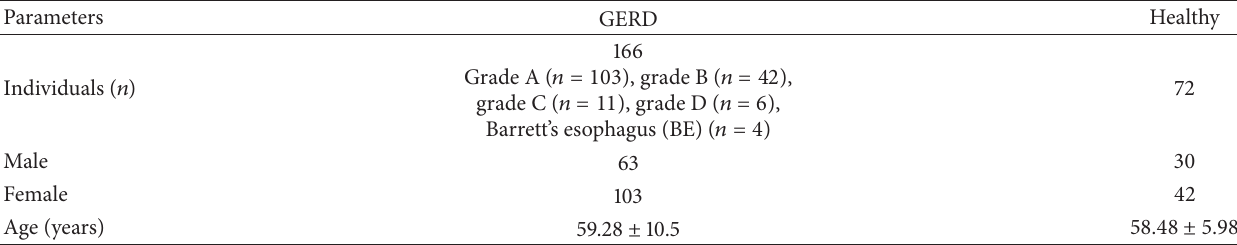
Table 1: Clinical characteristics of GERD and healthy control